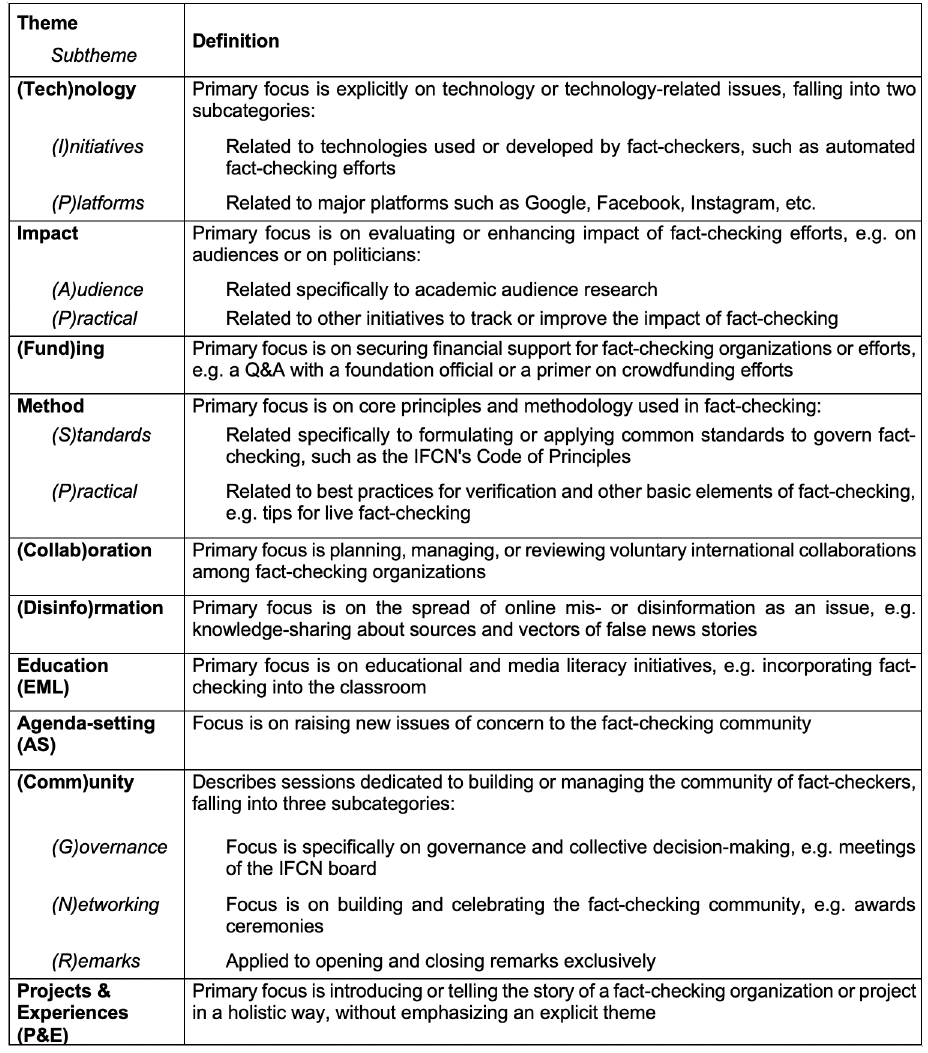
Table 2: Thematic